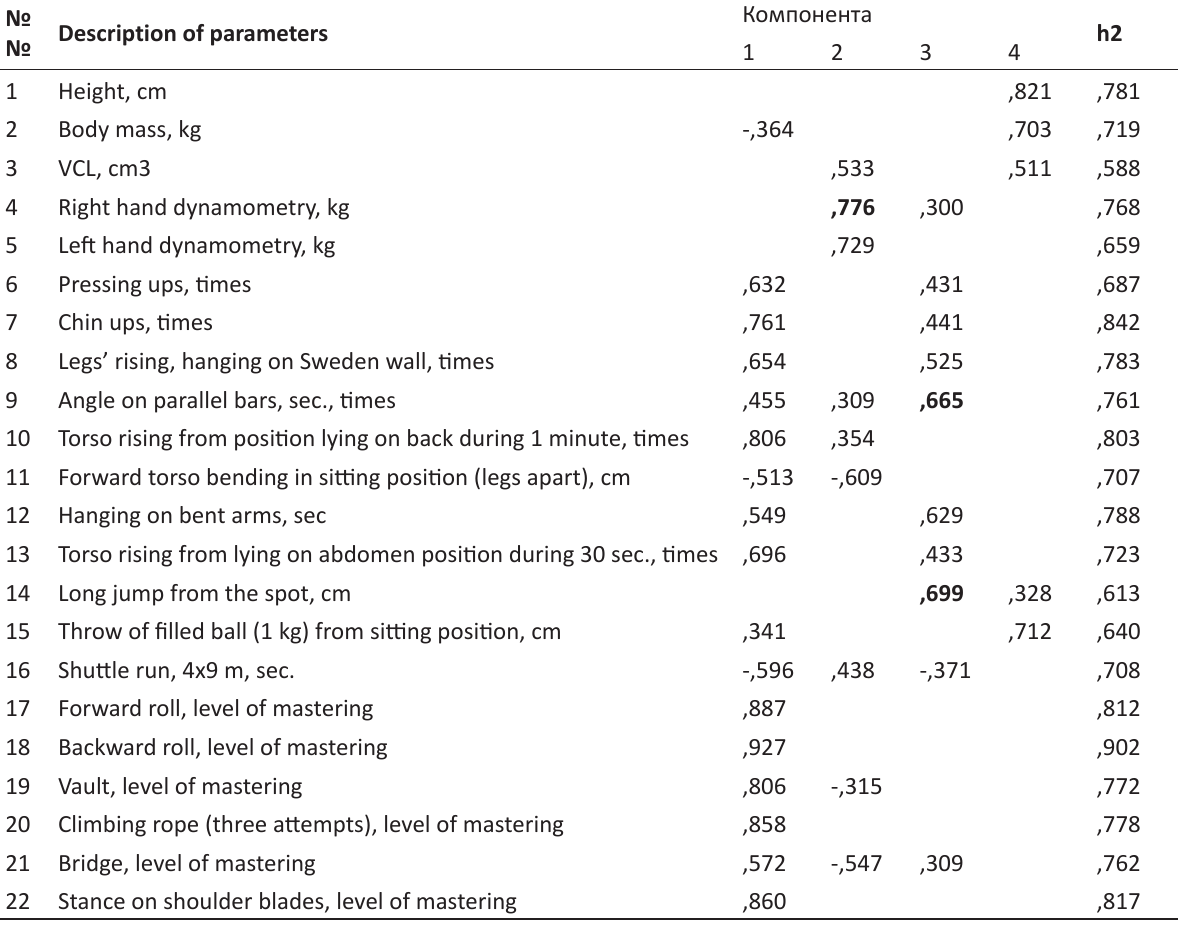
Table 4. Matrix of actorial analysis of 12 yrs boys’ testing. Rotation method: Varimax with Kwiser’s normalization